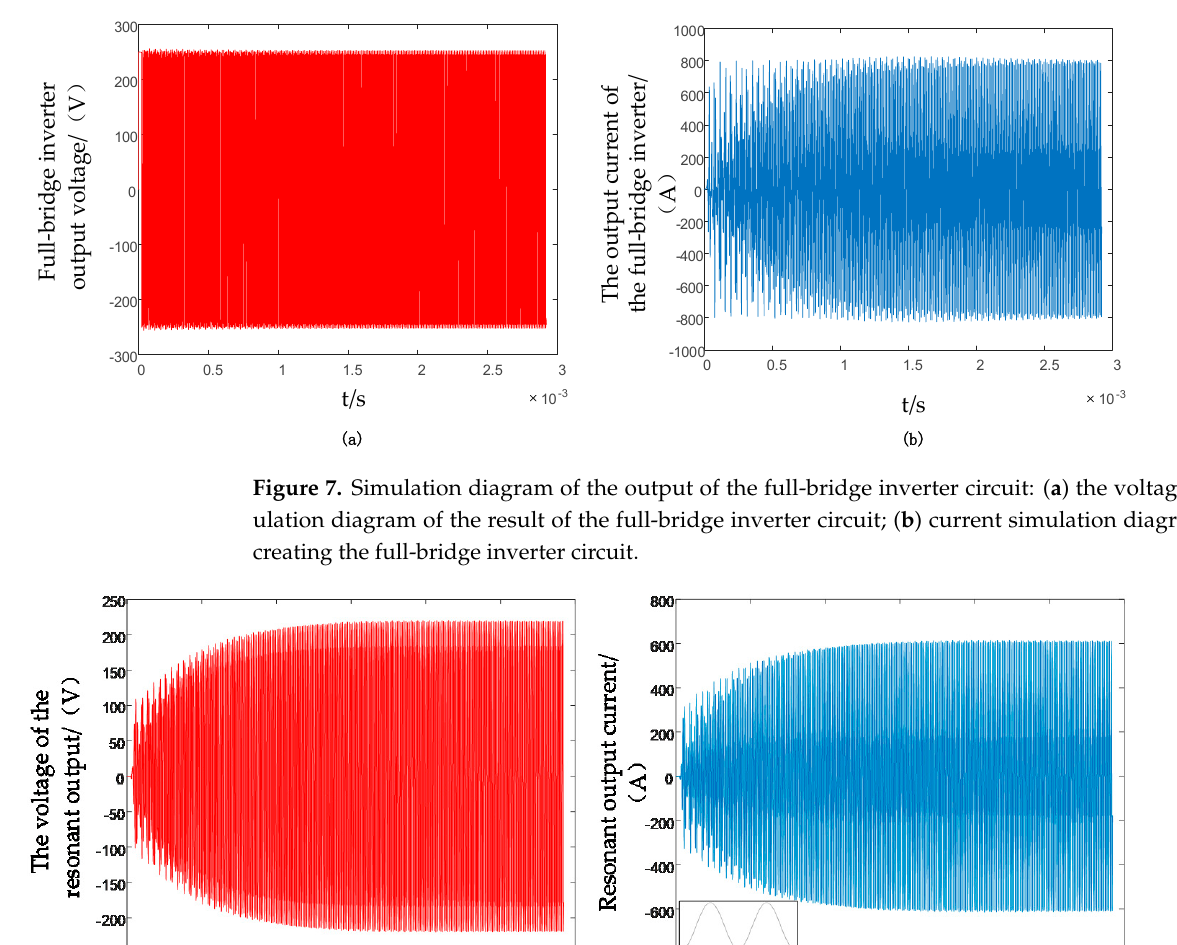
Figure 9. Simulation plot of the output voltage under controlled load variation. 5.4. Output Voltage Stability Comparison of Variable Loads In the actual wireless energy transmission system, the load is not constant and sometimes changes, which requires real-time adjustment of the closed-loop system 0